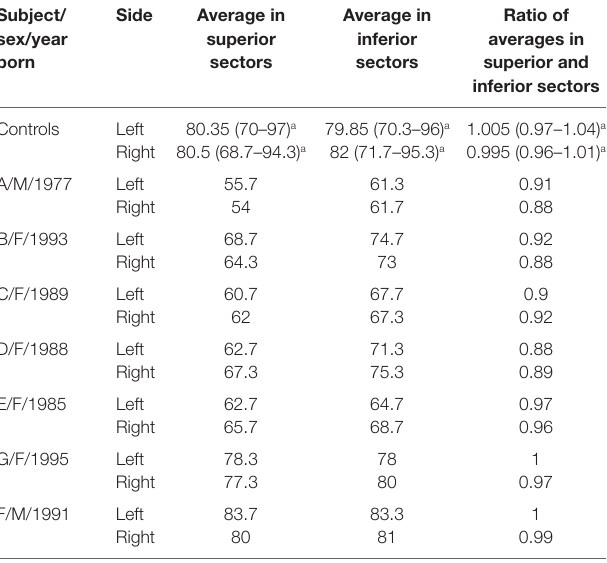
TaBle 2 | The GCL_ILP thickness in the eyes of patient and